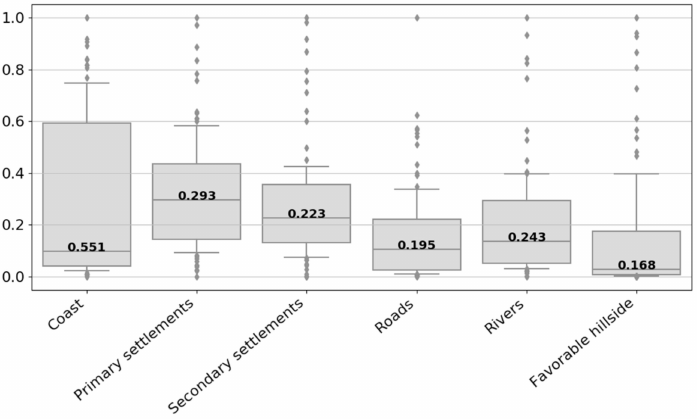
Figure 7. Boxplots of topographic location characteristics of sites on a normalized scale. The whisker lengthismodifiedtothate ff ect, thattheycorrespondtothedatabetweenthe12.5thand87.5thpercentiles. The value written in the box shows the interquartile range ( IQR norm ) of the respective dataset.